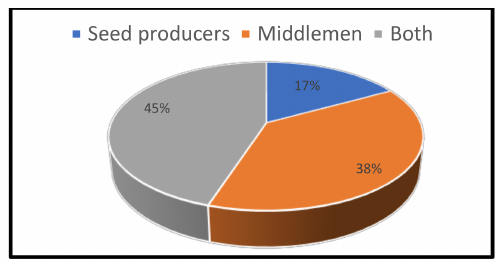
Figure 8. Collection of vegetable